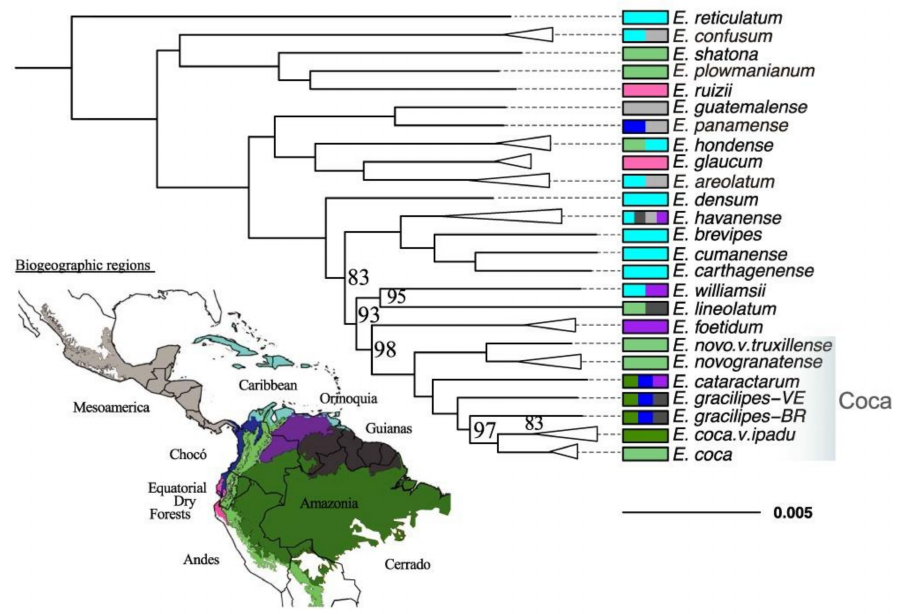
Figure 1. Phylogeny of the Erythroxylum genus. Colors on the map and the bars next to the names indicate the biogeographic regions where the species are naturally distributed. Numbers on the nodes indicate bootstrap support, which is 100% where not indicated. Modification of the phylogeny, inferred by White et al. (2019) [28] in the American Journal of Botany, 106(1), p. 158, is republished with permission from the Botanical Society of